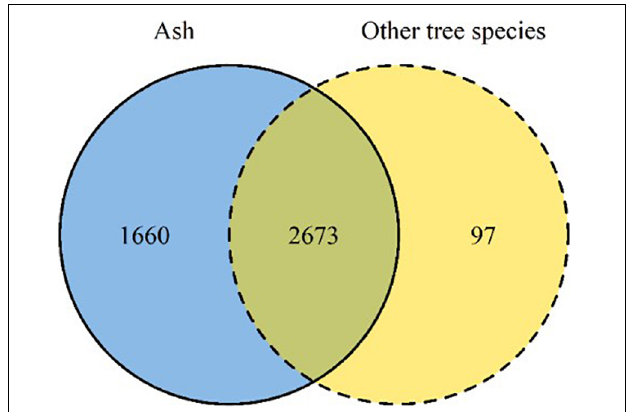
FIGURE 3 | Venn diagram summarizing the number of OTUs detected in ash (solid line, blue) and in neighboring tree species (dashed line, yellow). The overlapping area of the two circles reports the number of OTUs shared between ash and neighboring tree species.